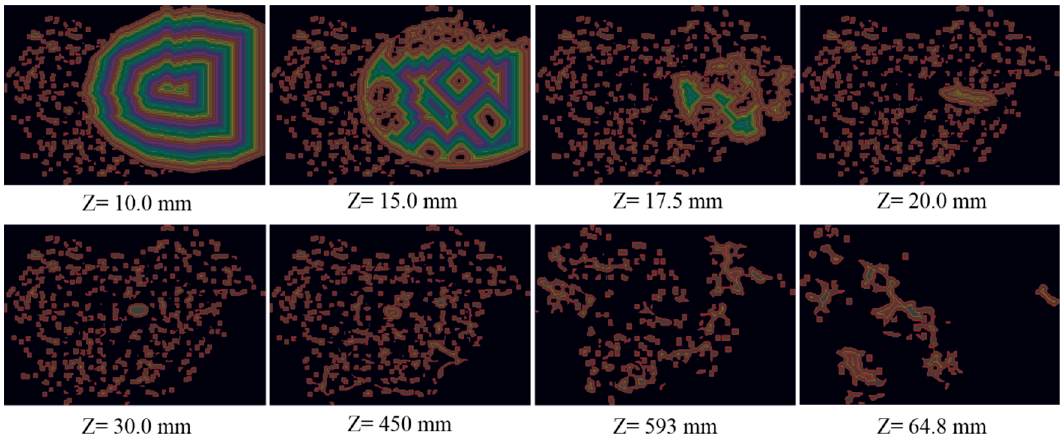
Figure 11. 2D slices of the bonsai model and the toolpaths generated by the hatching process. The infilling pattern is a dense grid.